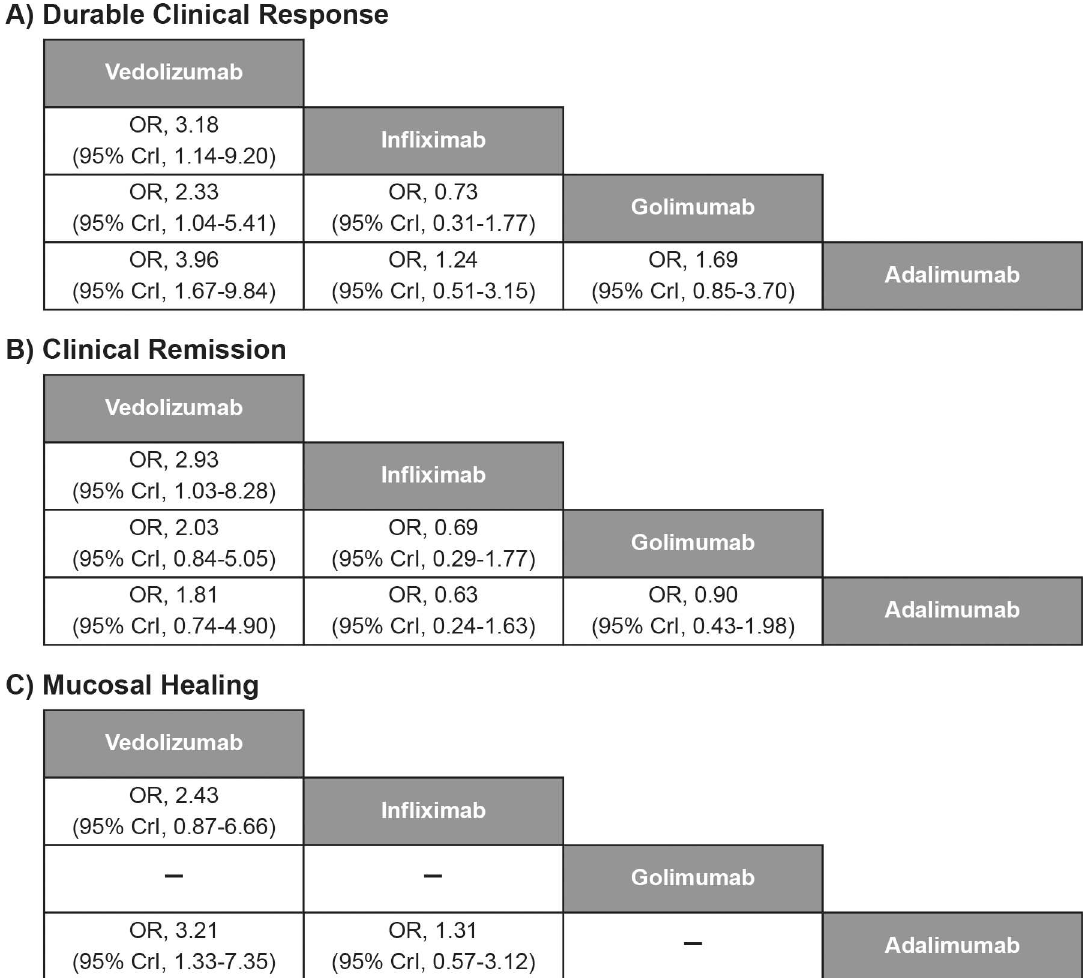
Fig 6. Comparative efficacy of biological agents as maintenance therapy for anti-TNF therapy-na ï ve subpopulation. CrI, credible interval; OR, odds ratio; TNF, tumour necrosis factor. Note: Treatment effect estimates come from Bayesian mixed-treatment comparison. ORs > 1.0 favour the treatment in the left upper square. To obtain ORs for comparison in the opposite direction, reciprocals shouldbe calculated.